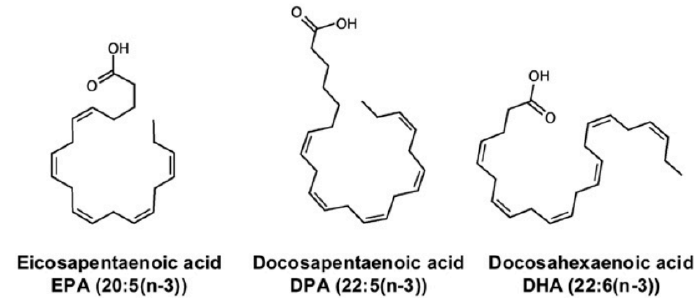
Figure 4. The long-chain n-3 polyunsaturated fatty acids: eicosapentaenoic acid (EPA), docosahexaenoic acid (DHA), and docosapentaenoic acid (DPA) [109] .